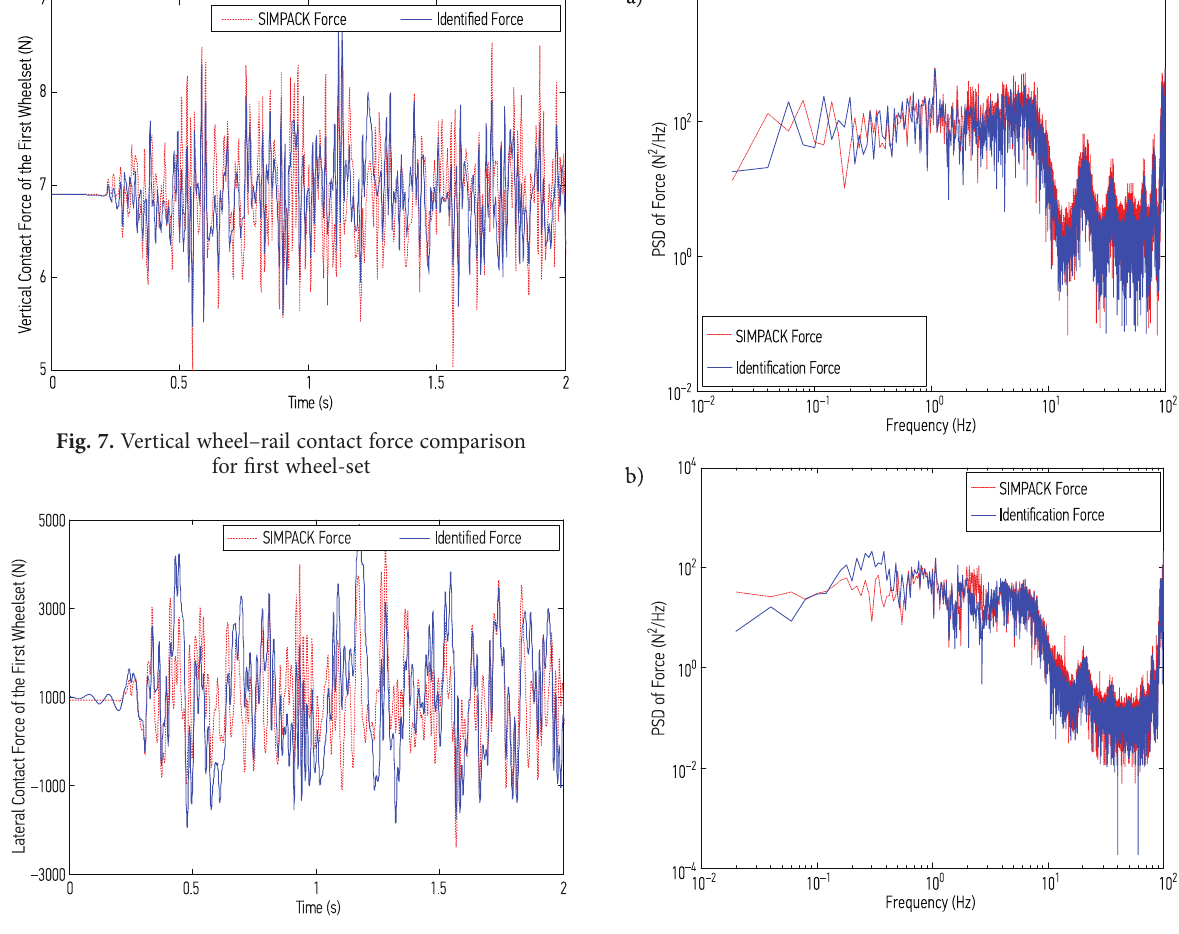
Fig. 8. Lateral wheel–rail contact force comparison for first wheel-set